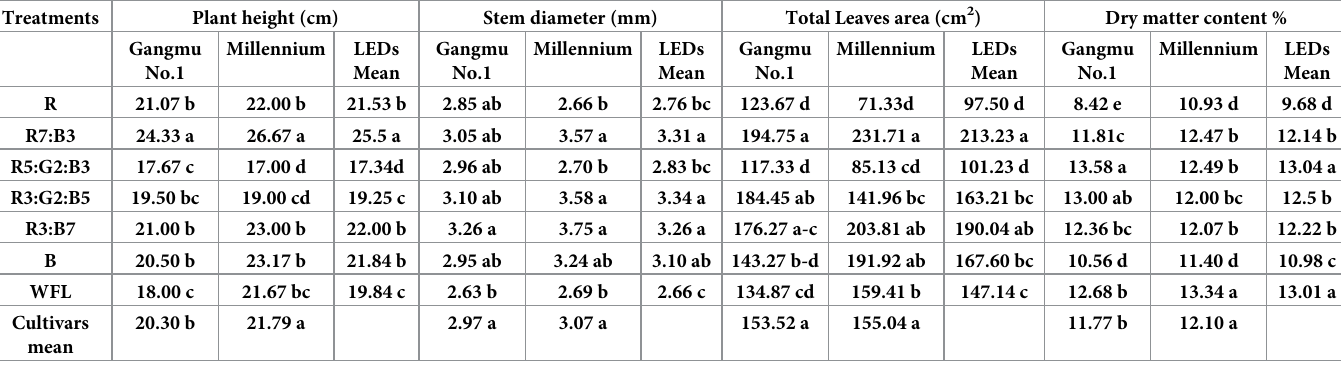
Values are means of three replicates. Different letters in the same column indicate significant differences according to Duncan’s multiple range test at P � 0.05. Where R = Red light 100%, R7:B3 = Red70%+ Blue30%, R5:G2:B3 = Red50%+ Green20%+ Blue30%, R3:G2:B5 = Red30%+ Green20%+ Blue50%, R3:B7 = Red70%+ Blue30%, B = Blue light 100%, WFL = White Fluorescent